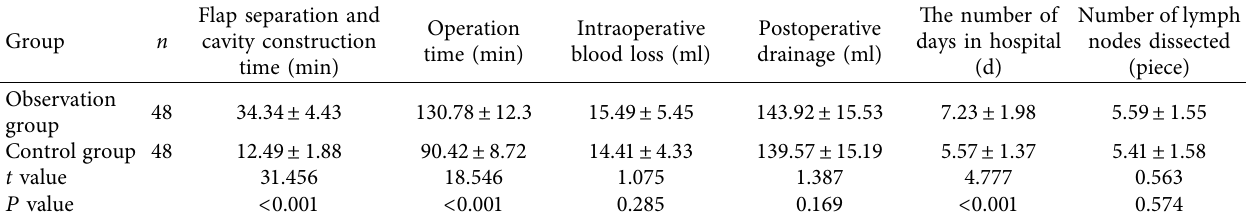
Table 2: Comparison of perioperative related indicators between the two groups ( x ± s